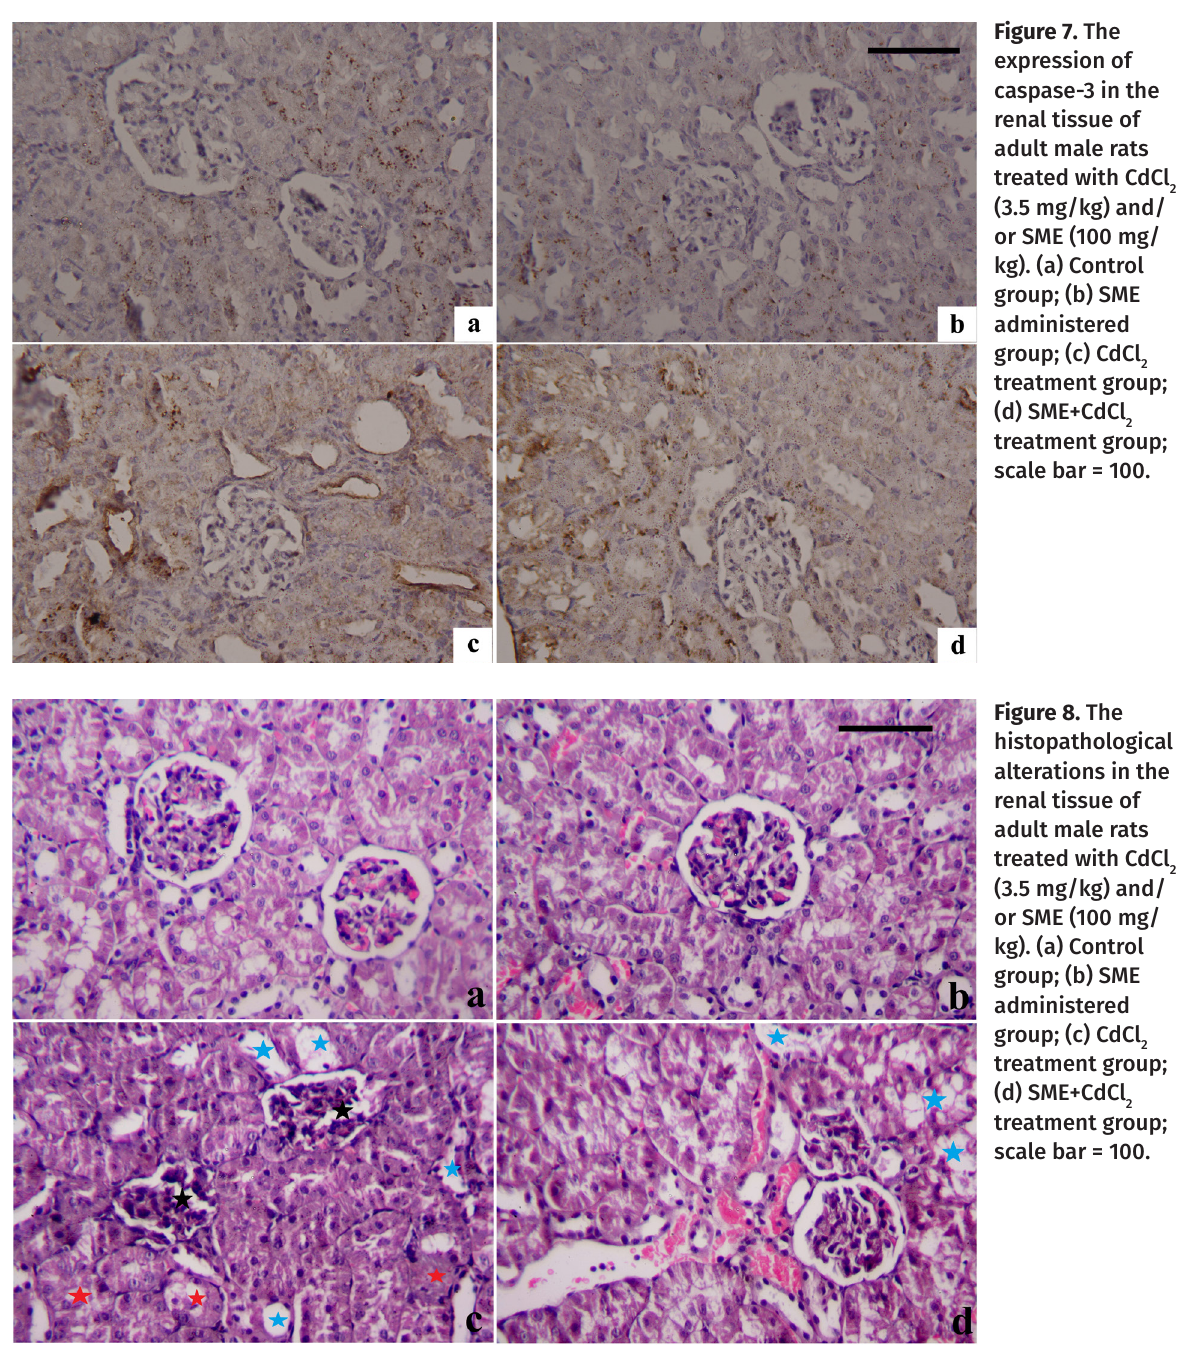
Figure 8. The histopathological alterations in